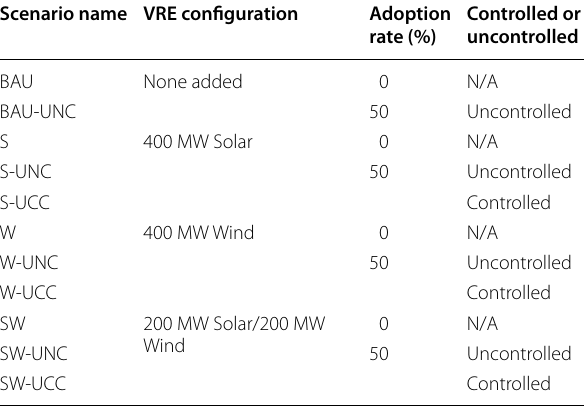
Table 3 Scenario matrix Scenario name VRE